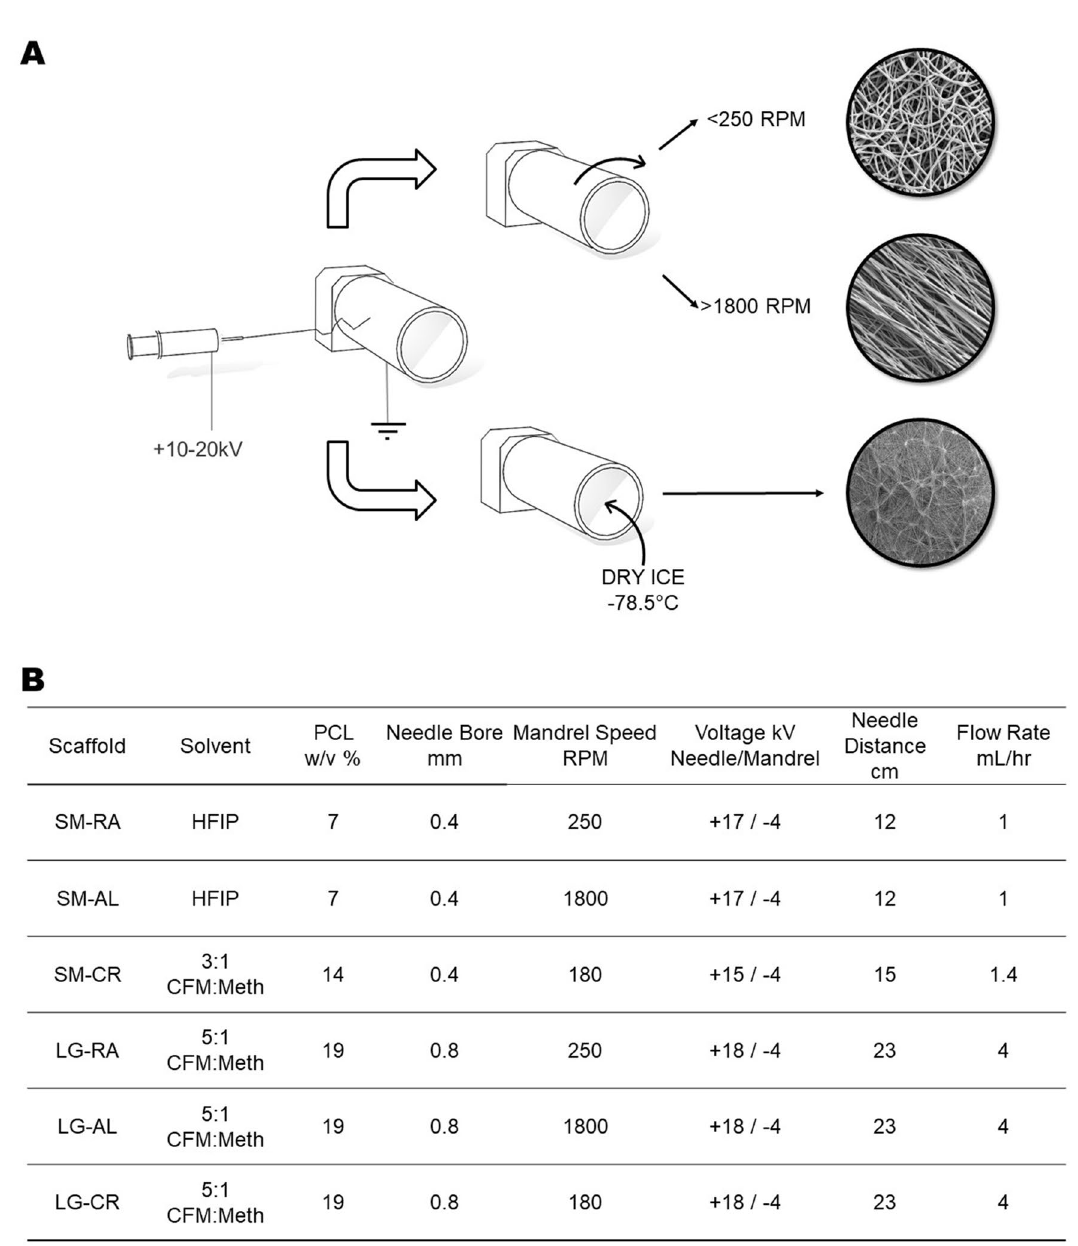
Figure 8. ( A ) Diagram depicting the electrospinning process for random, aligned and cryogenic fibres (top to bottom, respectively). ( B ) Table showing electrospinning parameters for each scaffold group. ( CFM:Meth